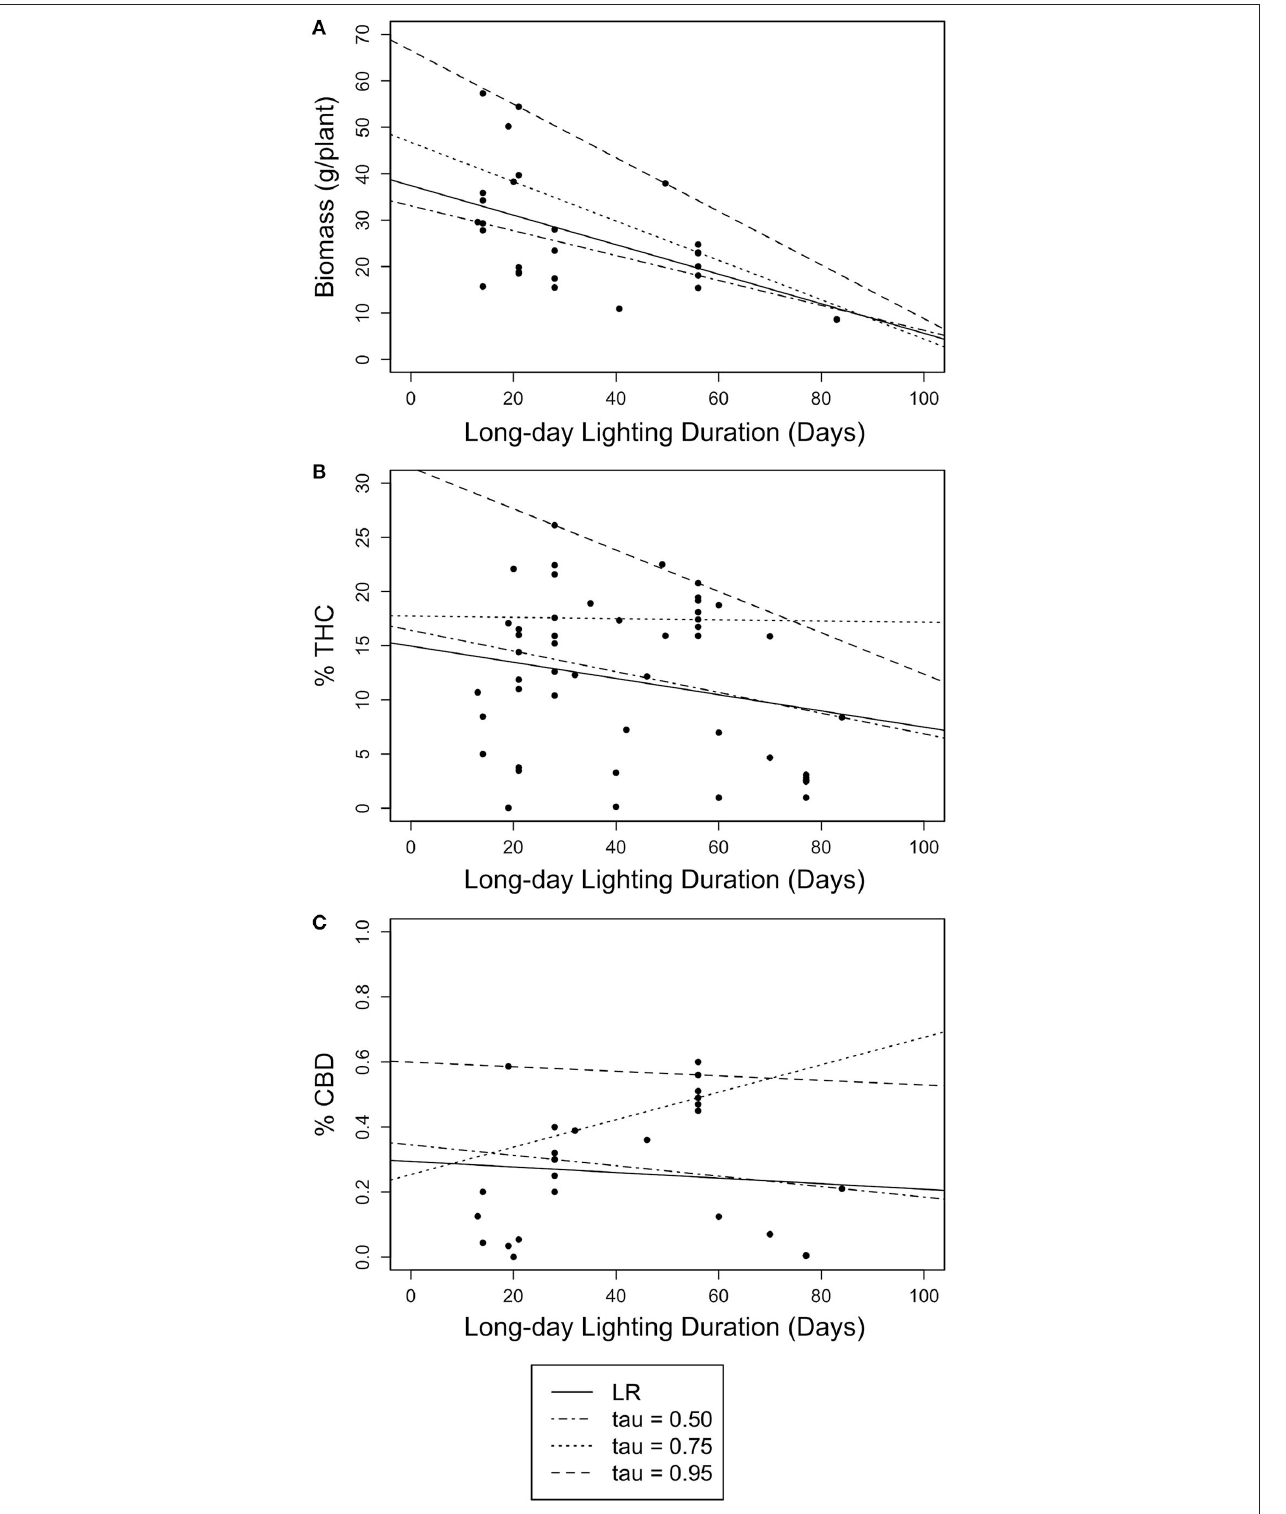
FIGURE 2 | Scatter plots of linear quantile regression results for long and short daylength durations (days) with floral biomass (g/plant) and cannabinoid concentration (% THC and % CBD). Lines represent simple linear regression (LR) (solid) and 50th (dotted-dashed), 75th (dotted), and 95th (dashed) linear quantile regressions. (A) The relationship between long daylength duration and floral biomass (g/plant). (B) The relationship between long daylength duration and THC concentration (% THC). (C) The relationship between long daylength duration and CBD concentration (% CBD).